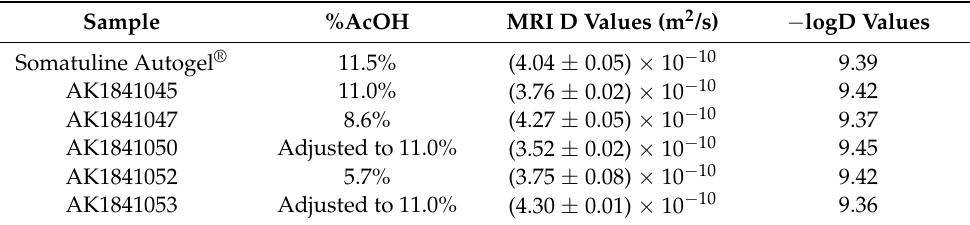
Table 2. Diffusion (D) values (m 2 /s) and the respective − logD transformation calculated from MRI DWI on each sample.